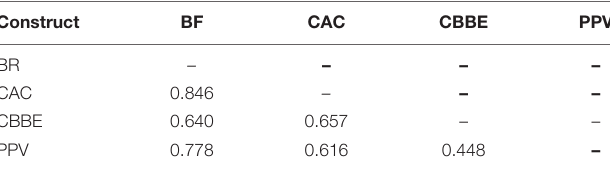
TABLE 3 | Discriminant validity (HTMT).